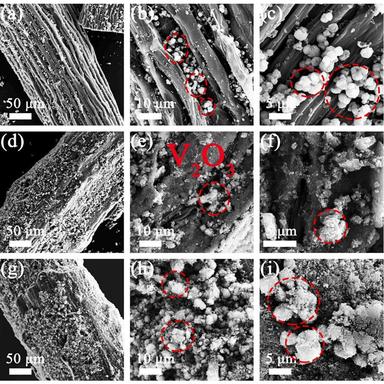
SEM images of (a-c) V2O3@CCN-11/2, (d-f) V2O3@CCN-15/2 and (g-i) V2O3@CCN-20/2.